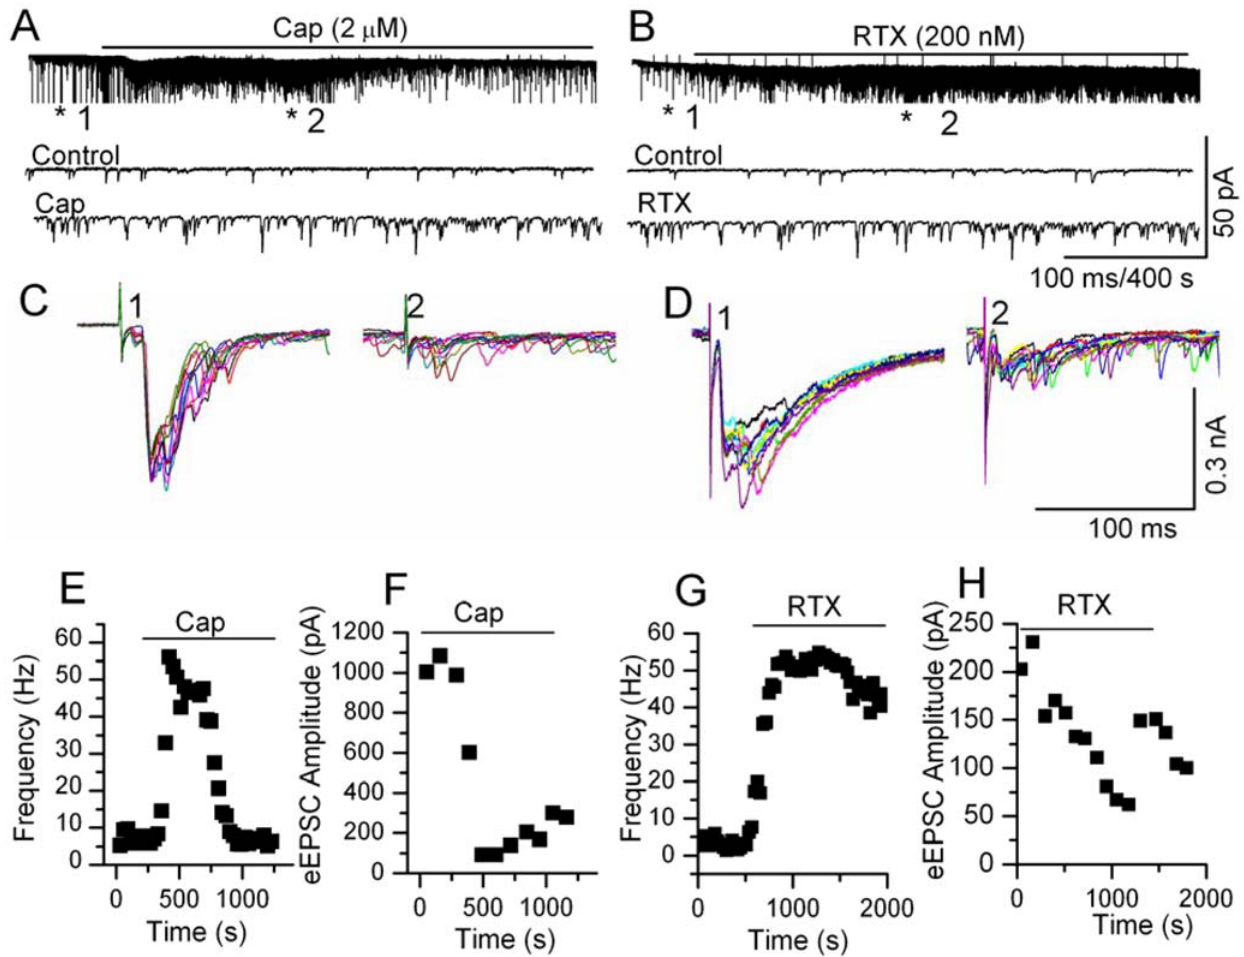
Figure 3. Modulation of synaptic transmission by activation of TRPV1 at the first sensory synapse in the CSTN. A, B. Application of capsaicin (2 m M) or RTX (200 nM) increased the frequency of sEPSCs. Capsaicin-induced response desensitized with time, whereas RTX-induced response was sustained. The evoked responses are truncated in A and B. The currents are shown at higher time resolutions below. C, D. Evoked synaptic responses were recorded from the same neurons before and after administration of capsaicin or RTX. In the presence of both capsaicin and RTX, eEPSCs either failed or exhibited a reduction in amplitude. E, F. Capsaicin-induced increase in sEPSC frequency decreased with time and the eEPSC amplitude remained depressed, G, H. RTX-induced increase in sEPSC frequency remained elevated, but the amplitude of eEPSC remained depressed.